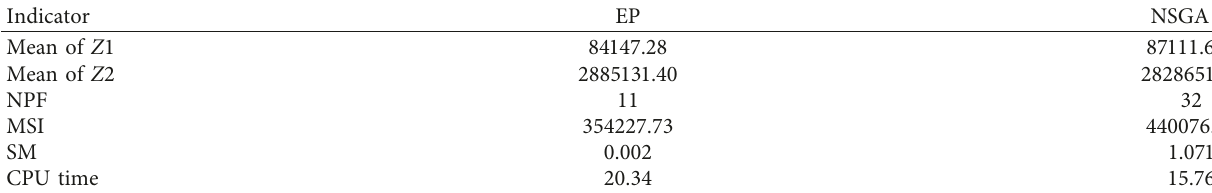
Table 11: Comparison indicators of problem solving methods.